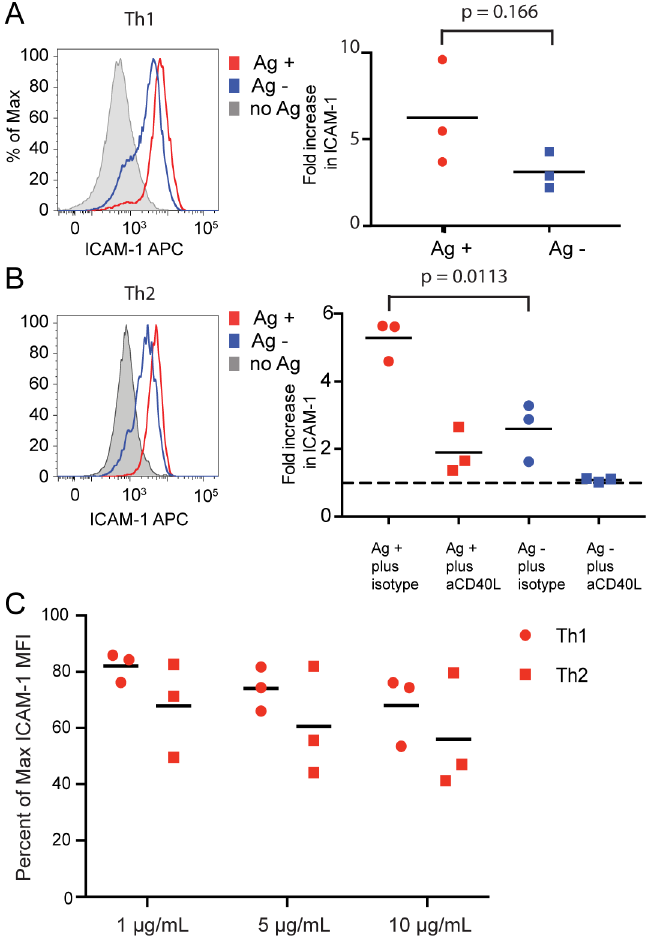
Fig 4. In the absence of anti-CD40L or CsA, Th2 deliver help preferentially to antigen-presenting B cells, and inhibition of Th2 help by anti-CD40L is comparable to that of Th1 cells. ICAM-1 was measuredon antigen-pulsed (Ag+) and bystander(Ag-) B cells mixed and incubatedovernight with Th1 ( A ) or Th2 cells ( B ). The inhibitionof Th2 help by additionof anti-CD40Lor isotype IgG control at 10 μ g/ml is shown in ( B ). Results are shown for three independentexperiments. ( C ) Inhibitionof help for antigen-presentingB cells by Th1 and Th2 cells is shown for a range of concentrations of anti-CD40L.The graph shows the percentage of maximum ICAM-1 fluorescent intensity in the presenceof anti-CD40Lblockingantibody. Results of three independentexperiments are